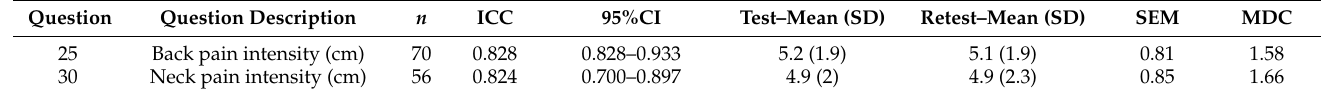
Table 5. Results of test-retest reliability of new continuous variables of